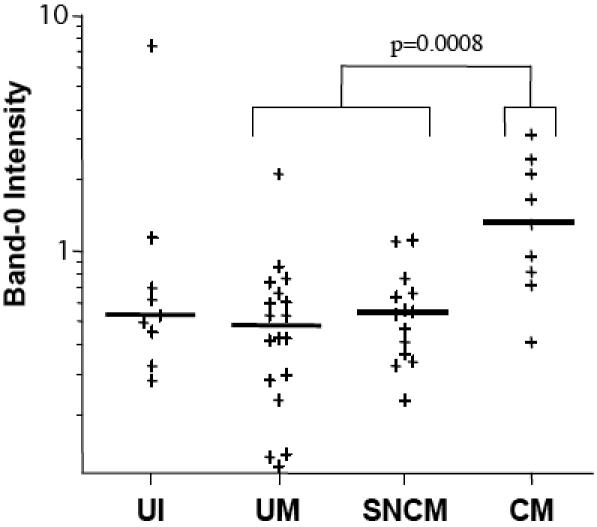
Mass fingerprinting.Proteins from human brain extract were separated on a 10% acrylamide gel. After Coomassie staining, three bands corresponding to reactive bands detected by Western blot were cut and their protein contents analyzed by peptide mass fingerprinting as described in the material and methods section. Three independent experiments were carried out and conducted to identical protein identifications. Results in figure 5 correspond to those obtain in one typical experiment.